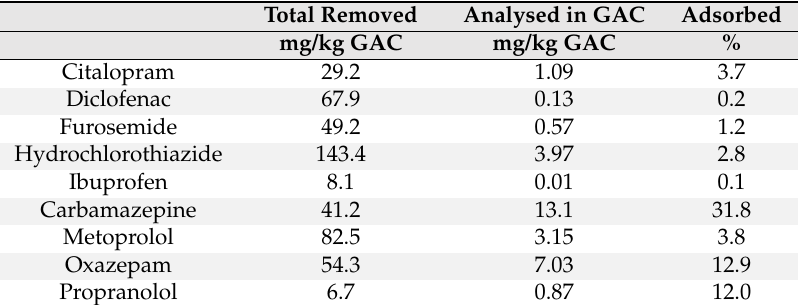
Table 1. Total amount of removed pharmaceutical residues in the GAC-biofilter. Total